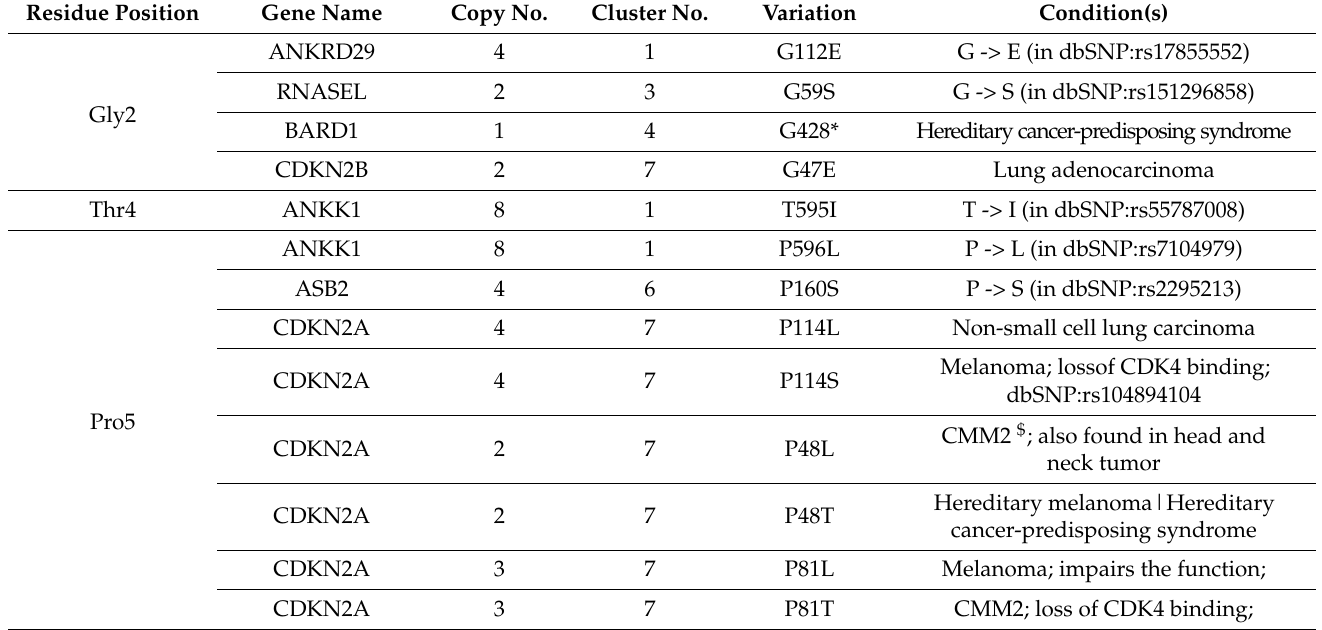
Table 3. Variations associated with the most conserved positions of the ankyrin